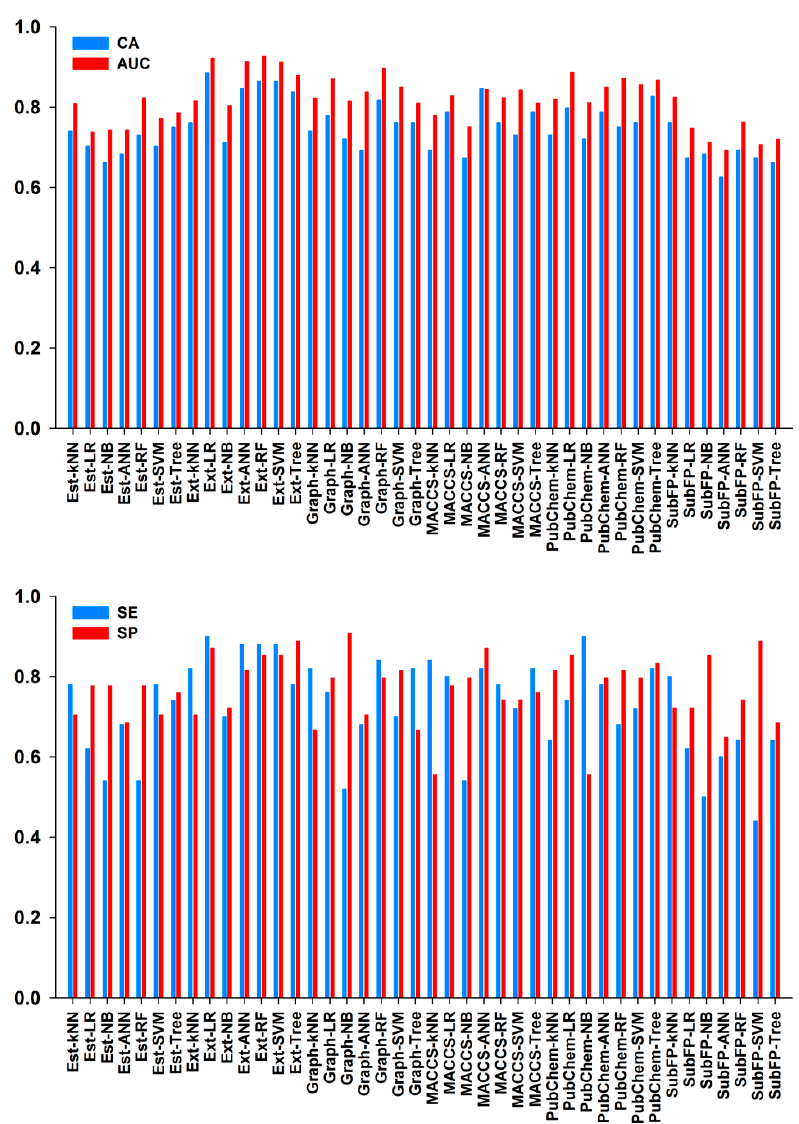
Figure 5. Performance of 10-fold cross-validation for the training set in 42 classification models. CA, AUC, SE and SP represent the classification accuracy; the area under the ROC curve, sensitivity and specificity, respectively.